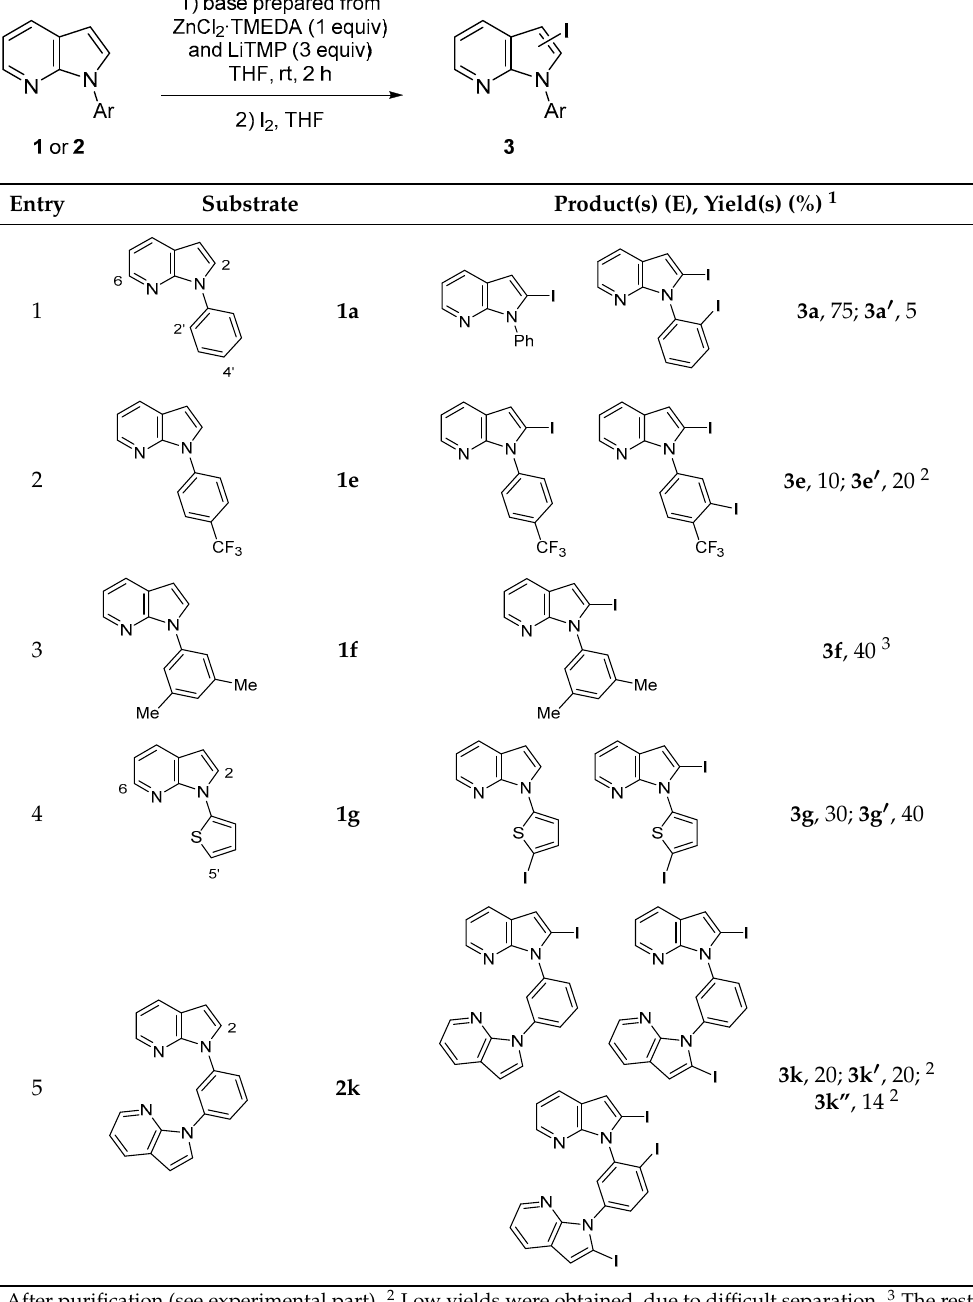
Table 2. Deprotometalation of the 1-arylated 7-azaindoles followed by iodolysis.